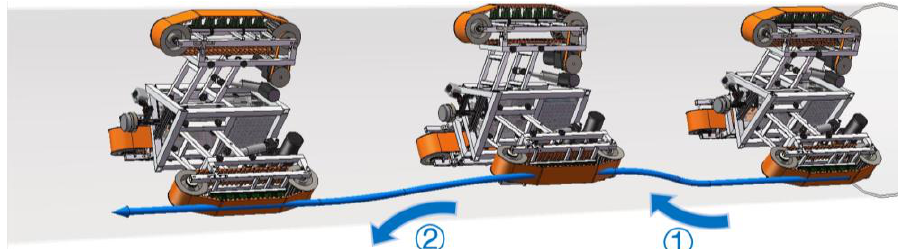
Figure 9. In-pipe robot positive-attitude control.